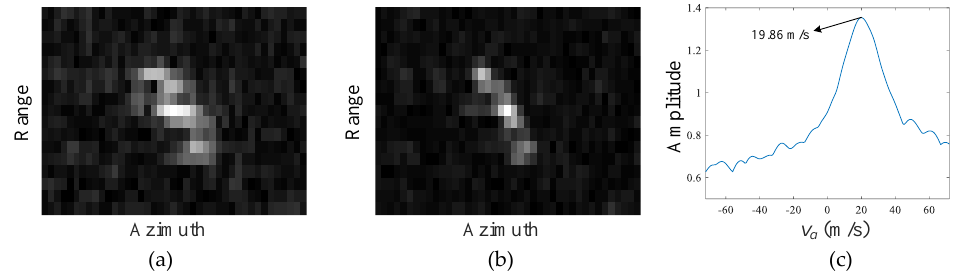
Figure 15. Along-track velocity estimation and refocusing of Target 12: ( a ) unfocused moving target; ( b ) refocused moving target; and ( c ) along-track velocity search curve.